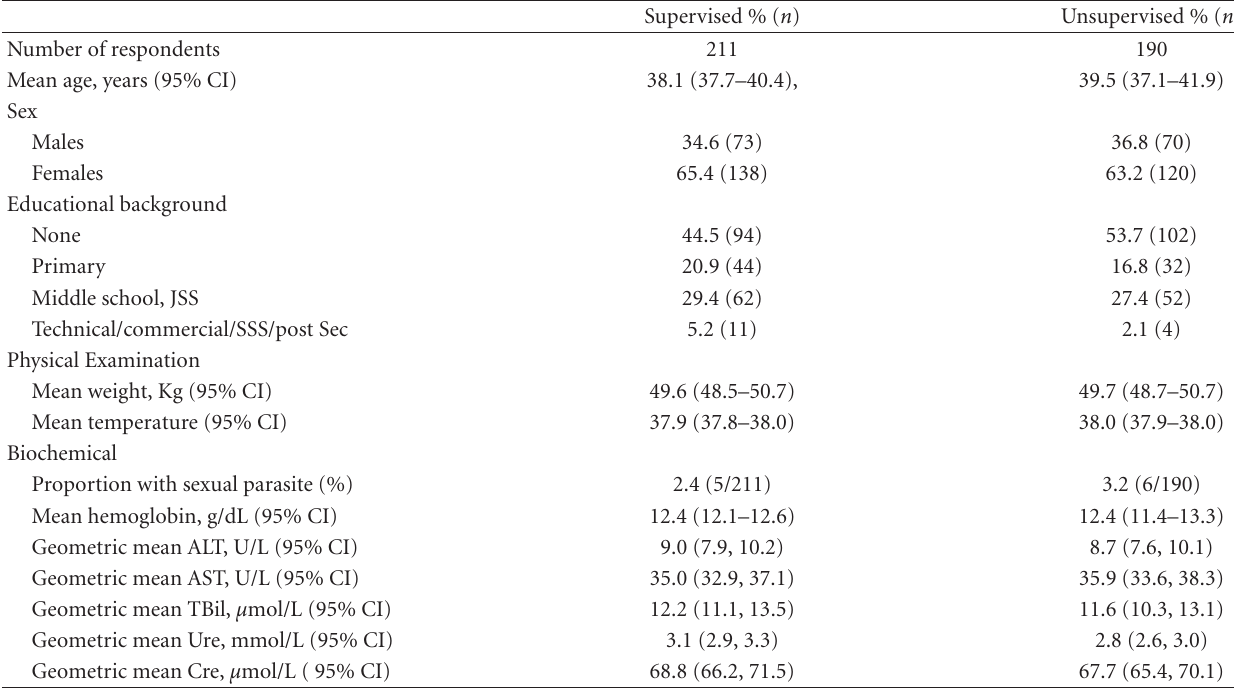
Table 1: Age, sex, and educational characteristics of study participants.